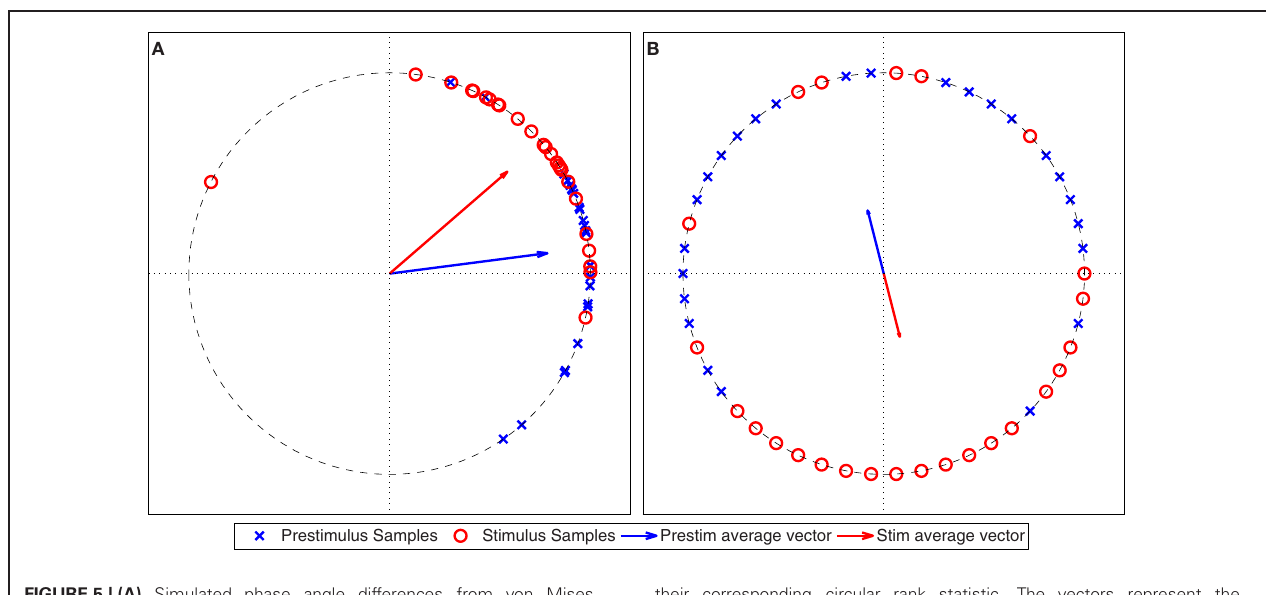
FIGURE 5 | (A) Simulated phase angle differences from von Mises distributions for a post-stimulus period ( θ = π /4, κ = 4) and a pre-stimulus period ( θ = 0, κ = 4). (B) Same data redistributed by